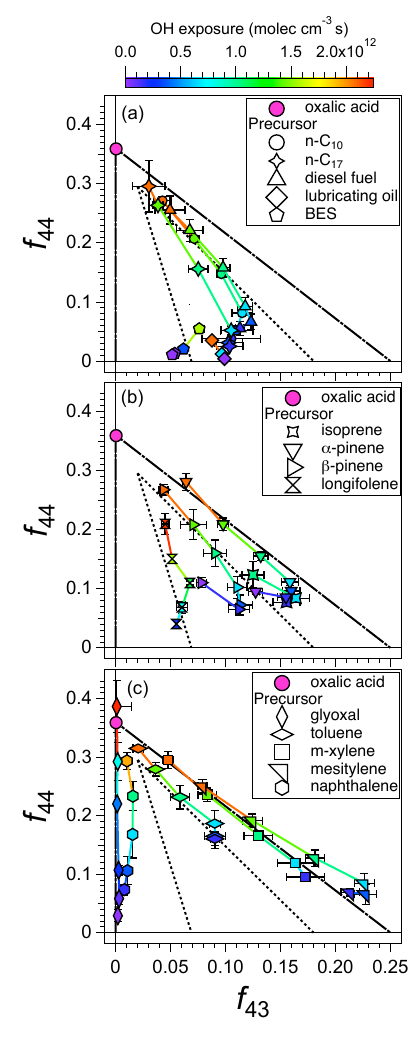
Fig. 2. f 44 shown as a function of f 43 for SOA and OPOA gen- erated in the PAM reactor from oxidation of (a) alkanes and BES, (b) biogenic terpenoids, and (c) aromatics and glyoxal. Symbols are colored by OH exposure; error bars represent ± 1 σ in measure- ments. Measured f 43 and f 44 of oxalic acid shown for reference. Dashed lines indicate range of ambient f 44 and f 43 measurements (Ng et al., 2010), while dashed-and-dotted lines indicate range of laboratory measurements. For details see